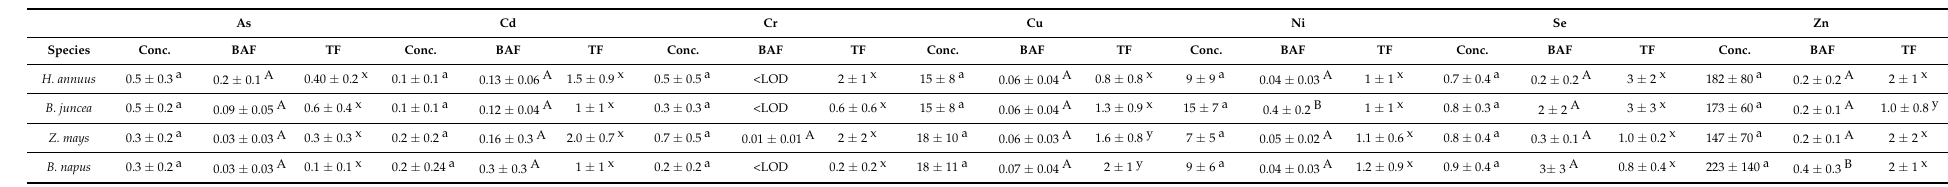
Table 3. Average shoot total metal concentration (mg/kg), metal bioaccumulation (BAF) and translocation (TF) factors in the four analysed plant species. Different letters indicate significant differences for the three different parameters among species (ANOVA/Kruskal-Wallis tests followed by Tukey HDS/Dunn’s test, p < 0.05). Total Pb level in shoots was below the detection limit and is not reported here as well as the related BAF and TF values. Complete datasets in Tables S2 and S3. As Cd Cr Cu Ni Se Zn Species Conc. BAF TF Conc. BAF TF Conc. BAF TF Conc. BAF TF Conc. BAF TF Conc. BAF TF Conc. BAF